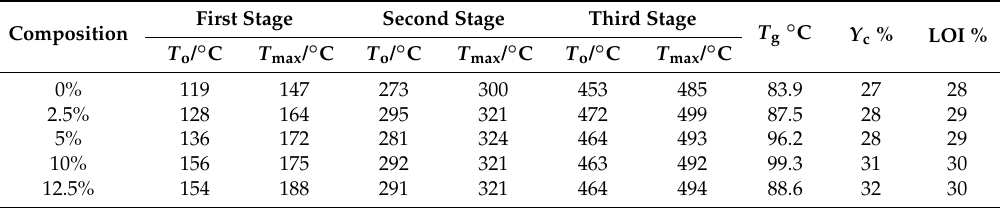
Table 1. Thermal properties of PAI/PANI/CB ternary blends with different compositions.